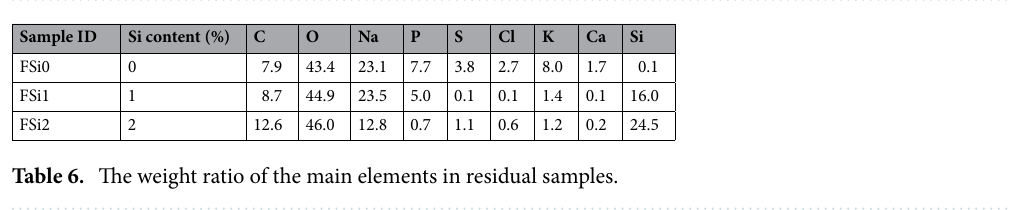
Figure 15. EDS analysis on FSi2 sample ( a ) selected area on FSi2, ( b ) main element mapping on surface, ( c ) element mapping of C, ( d ) element mapping of O, ( e ) element mapping of Na, ( f ) element mapping of P, ( g ) element mapping of Si, ( h ) element mapping of Cl.